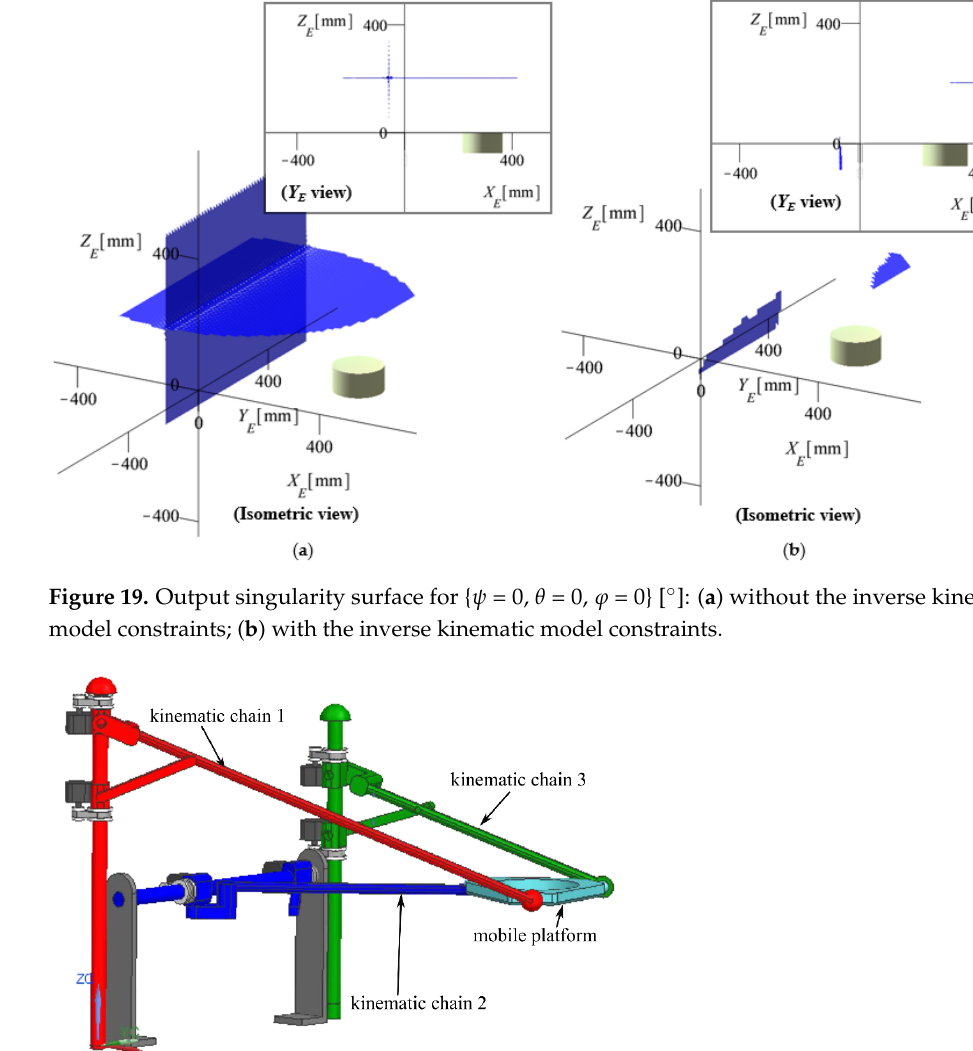
Figure 21. Output singularity surface for { ψ = 20, θ = 0, φ = 0} [°]: ( a ) without the inverse kinematic model constraints; ( b ) with the inverse kinematic model constraints.